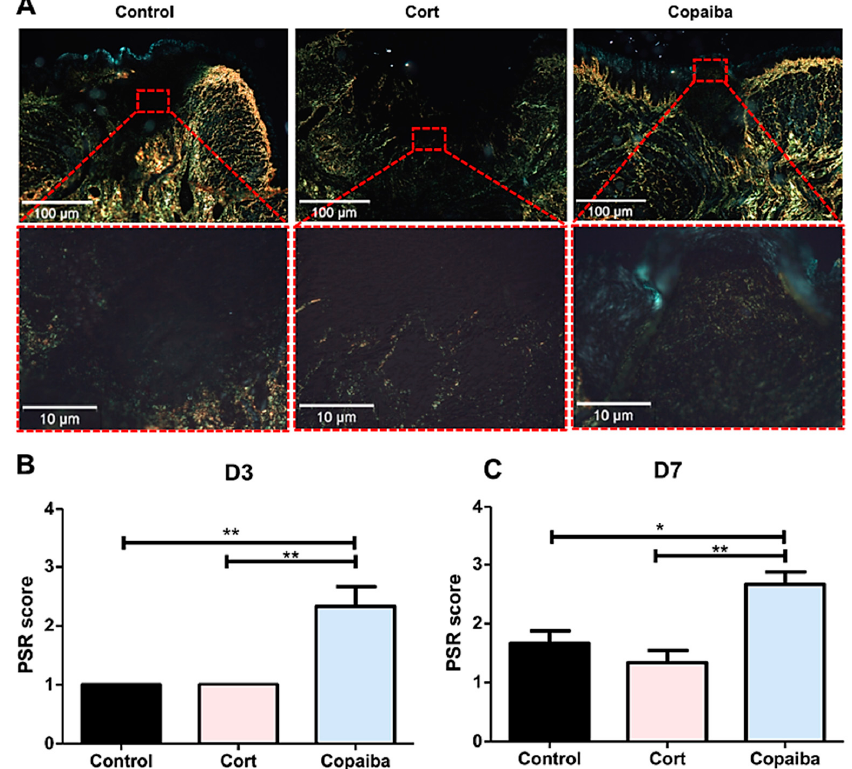
Figure 4. Photomicrographs of PicroSirius red staining. ( A ) Corticoid-treated and controls’ wound area showed a black area (especially on the surface), indicating the absence or a small number of collagen fibers. On the side and bottom of the wound, poorly organized thin collagen fibers were observed. Copaiba-treated wounds were filled with more organized collagen fibers. (PSR, original magnification, × 100 and × 400). ( B ) Graphs of collagen content analysis on D3 ( n = 15) and ( C ) D7 ( n = 15). Note that on D3 and D7, corticoid-treated and control groups showed less organized fibers than the copaiba-treated group (original magnification × 100 and × 400). One-way ANOVA followed by Tukey’s multiple comparison tests (* p < 0.05, ** p <